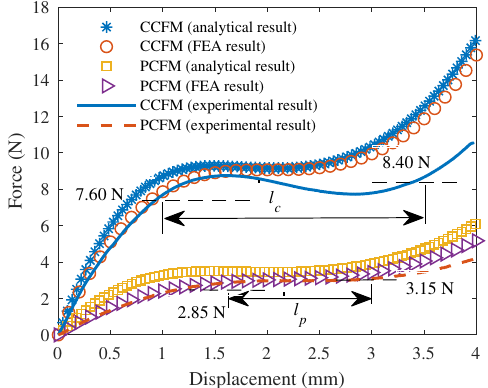
Figure 8. Constant-force range test results of the CCFM.